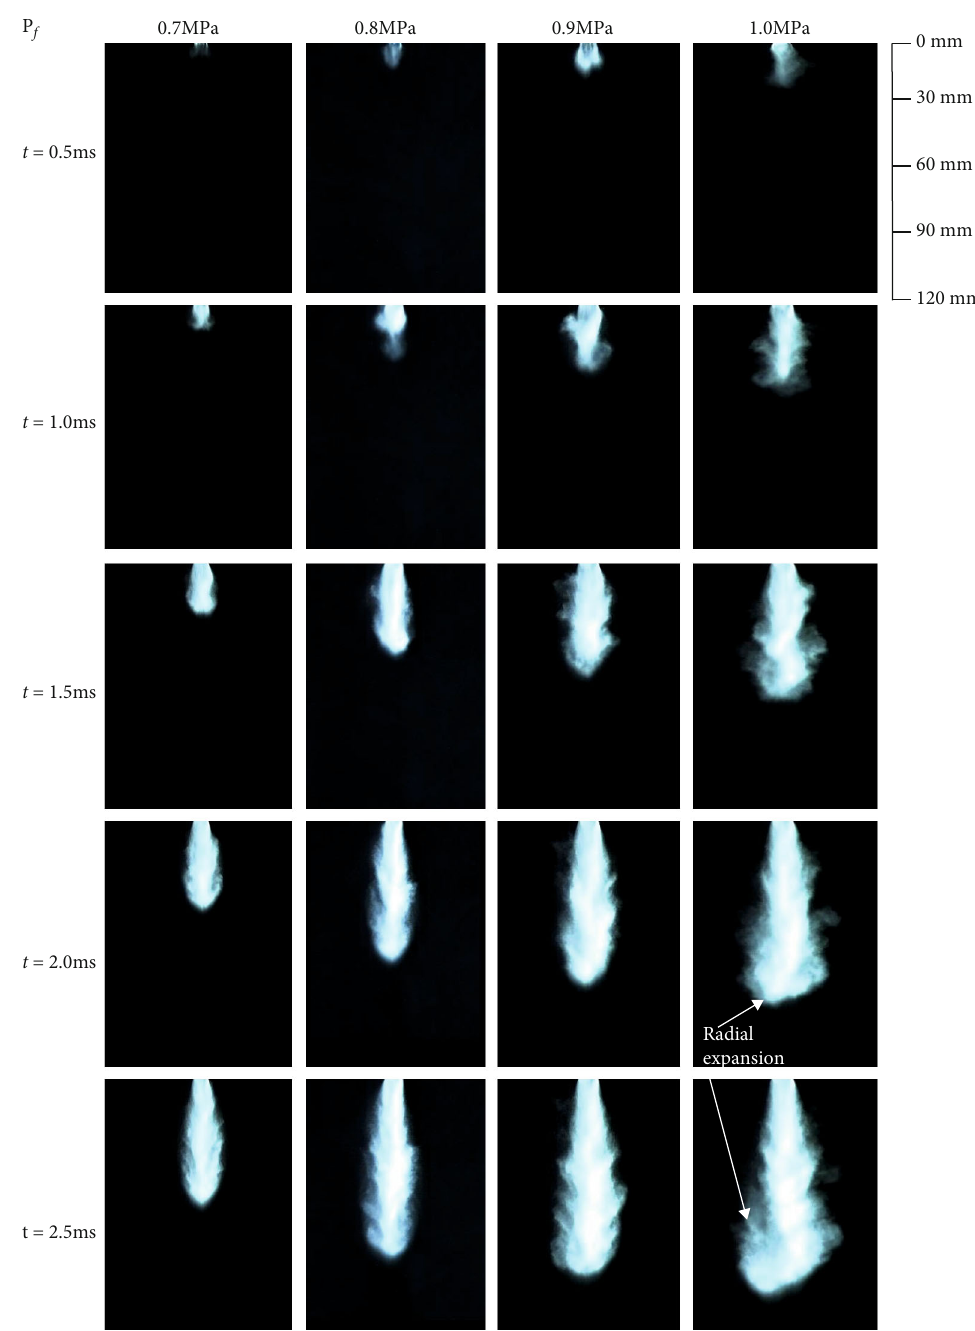
= 298 K , Δ T = 4 : 0 ms f f